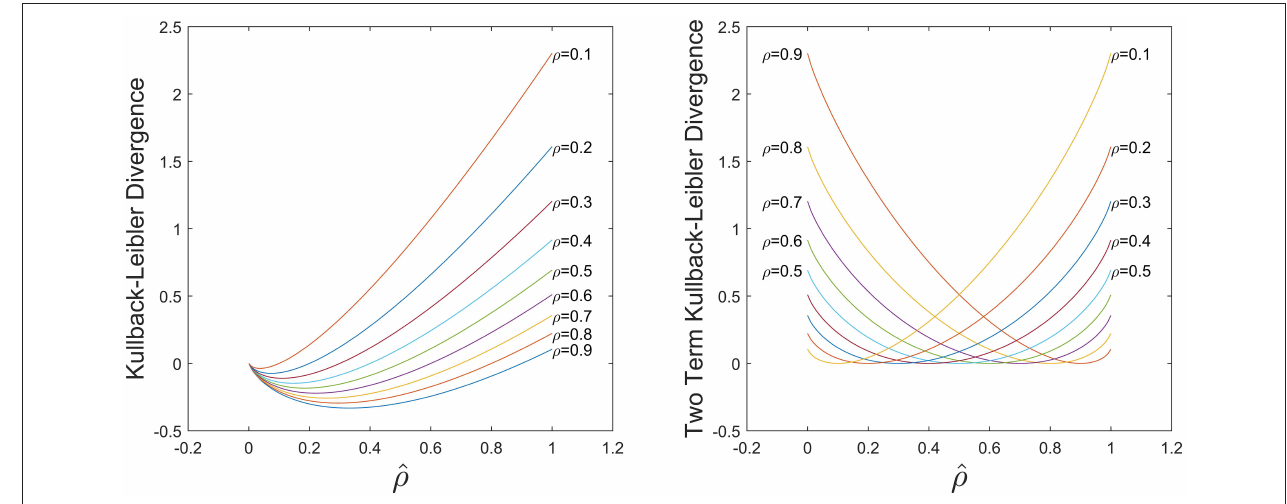
FIGURE 2 | Comparison of KL divergence in Equation (5) using only the first term (Left) and the both terms (Right) . With both terms the KL divergence is non-negative and symmetric for ˆ ρ = 0.5.